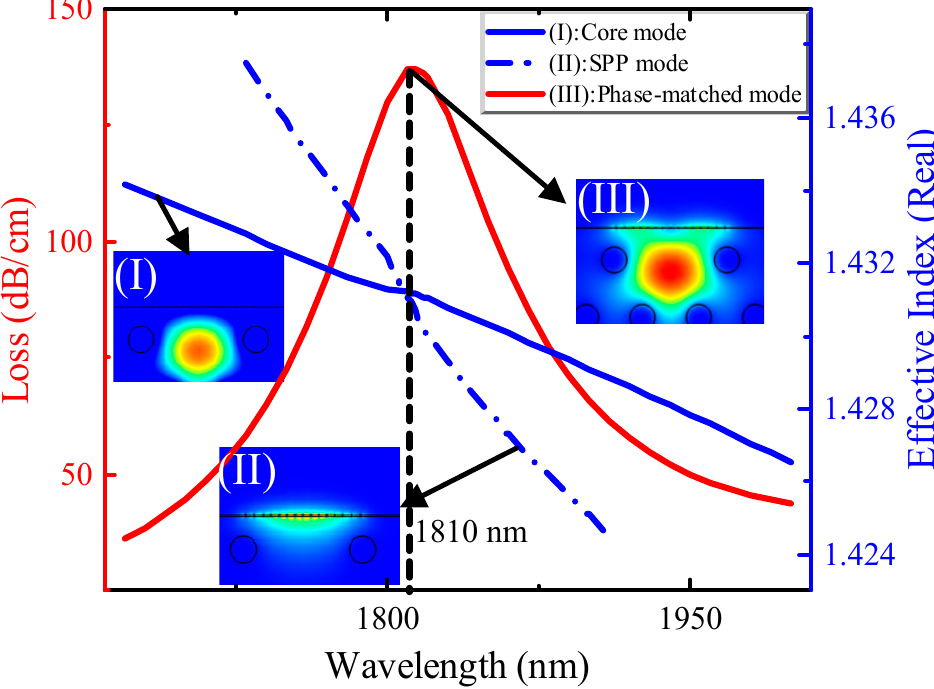
Figure 3. Dispersion relationship and mode analysis of the sensor.